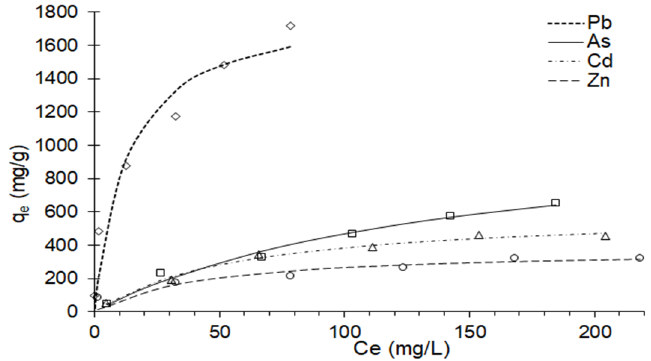
Figure 5. Isotherms fitted to the Langmuir model.